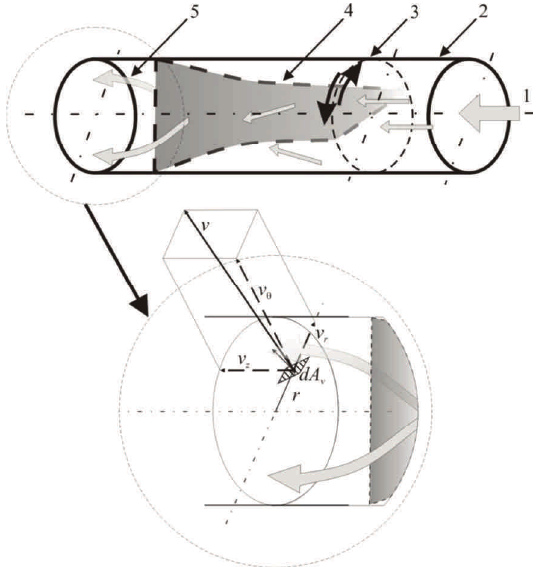
Fig. 7. Schematic of the flexible geometry element of inlet channel and velocity’s distribution for each point of swirling flux (dA v ) during intake process: r – inlet channel inner radius, v r – radial velocity, v z – axis veloci- ty, v 0 – normal velocity, v – mean velocity, 1 – inlet of air flux, 2 – wall, 3 – twisted the end of the flexible element (rotatable), 4 – flexible element, 5 – swirling air